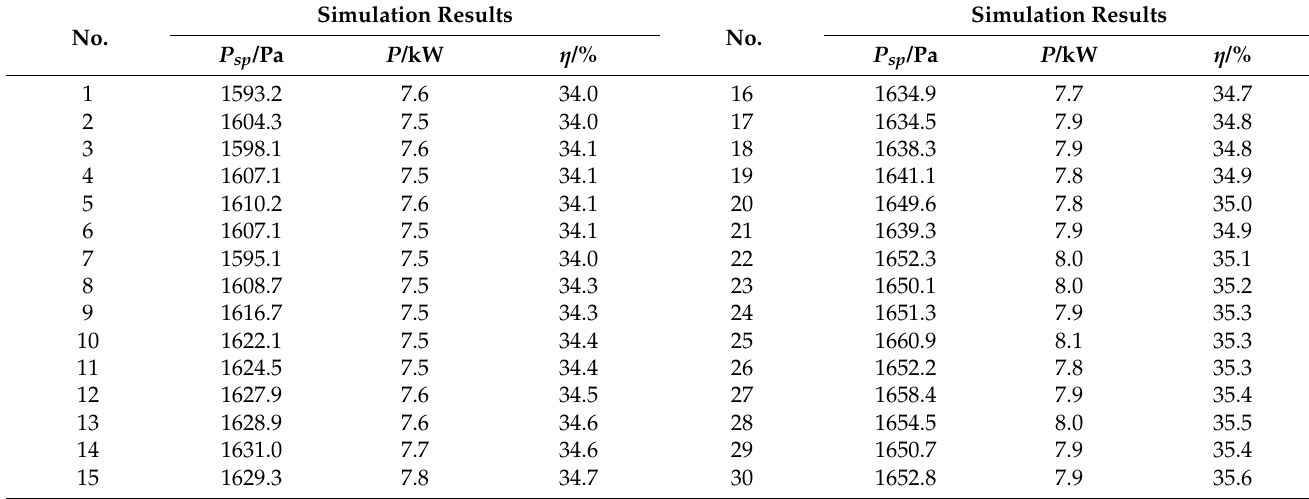
Table 2. Simulation results of 30